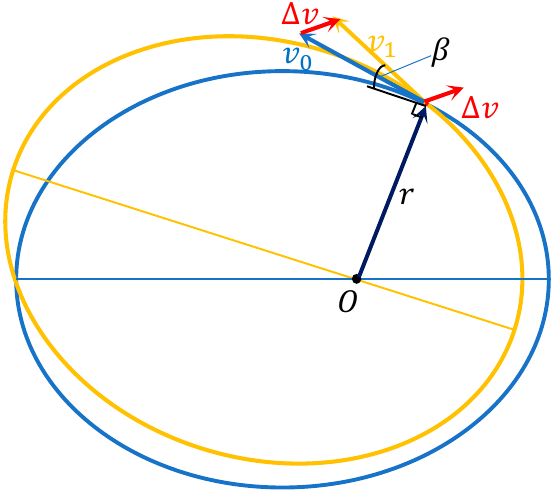
Figure 1. Schematic diagram of satellite orbit maneuvering.